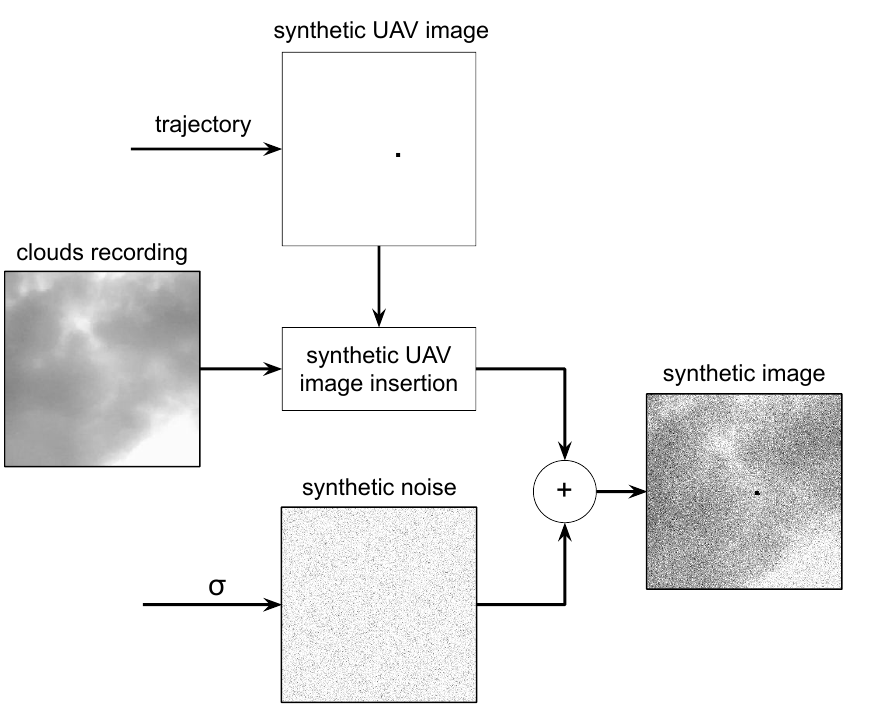
Figure 2. Augmentation